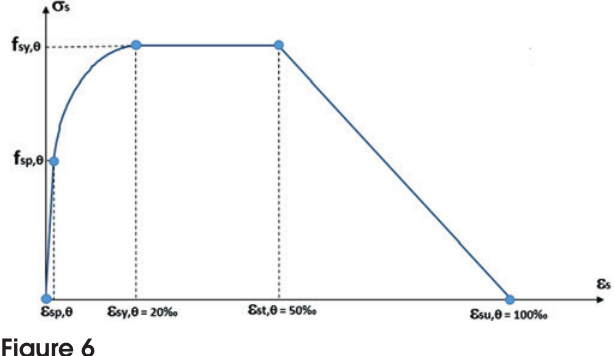
Stress-strain relationships for reinforcing